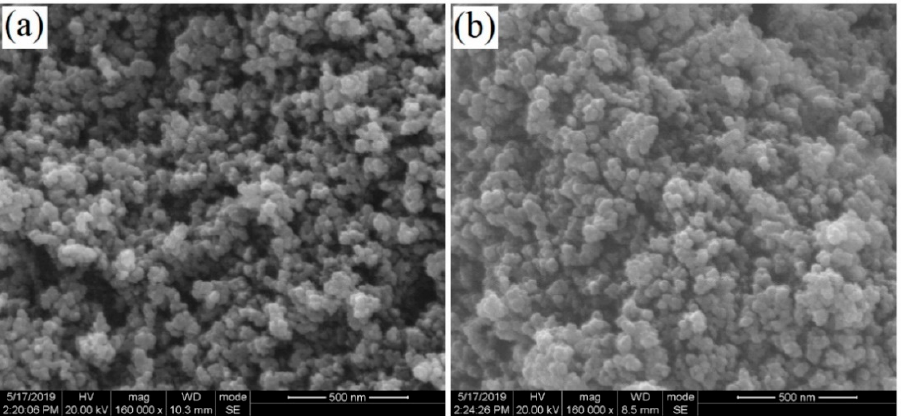
Figure 2. SEM images of ( a ) VXC-72R and ( b ) VXC-72R / ZrO 2 nanocomposites.